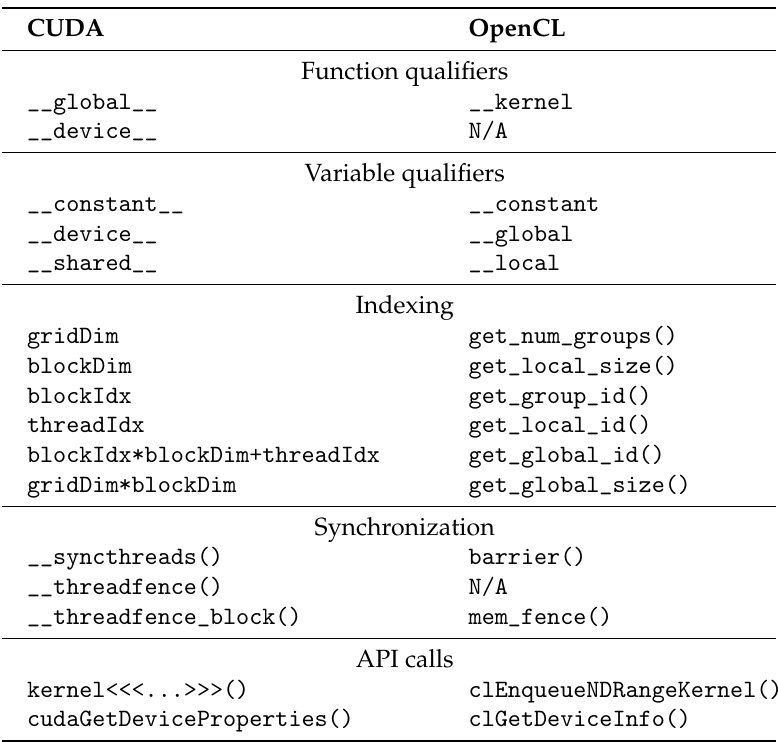
Table 3. Keywords, functions, and application programming interface (API) calls in CUDA and OpenCL. In many cases, a simple search and replace is sufficient to translate a